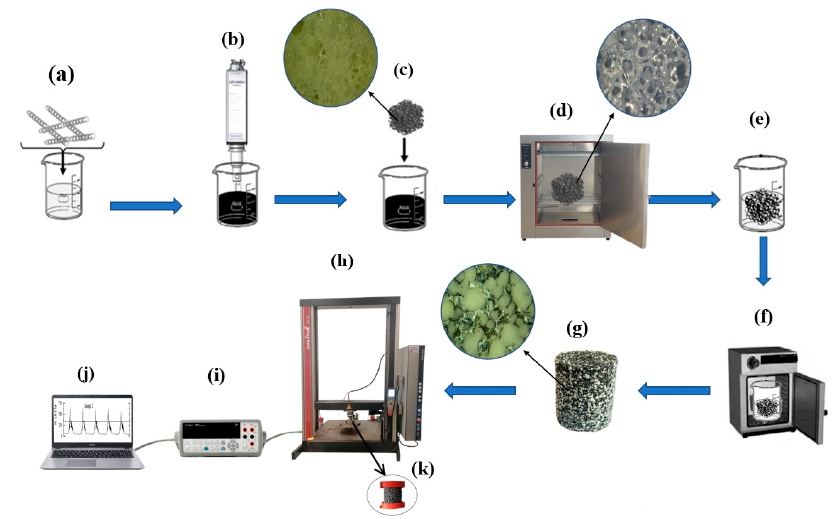
Figure 1. Schematic representation of the preparation and testing of the N-BCNT/PU-silicone rubber piezoresistive nano- composite. ( a ) Mixing N-BCNT with alcohol. ( b ) Dispersion of N-BCNT in alcohol by ultrasonication. ( c ) Dipping the PU samples into the N-BCNT solution and ( d ) drying the N-BCNT/PU system. ( e – f ) Vacuum impregnation of the N-BCNT/PU samples with silicone rubber. ( g ) Cutting the N-BCNT/PU-silicone rubber nanocomposite samples. The pressure response of the samples ( k ) has been tested by using a ( h ) tensile test device, ( i ) data recorder, and ( j ) computer to collect the data. Table 1. Ratios of silicone rubber, PU, and N-BCNT in the prepared N-BCNT/PU-silicone rubber samples.